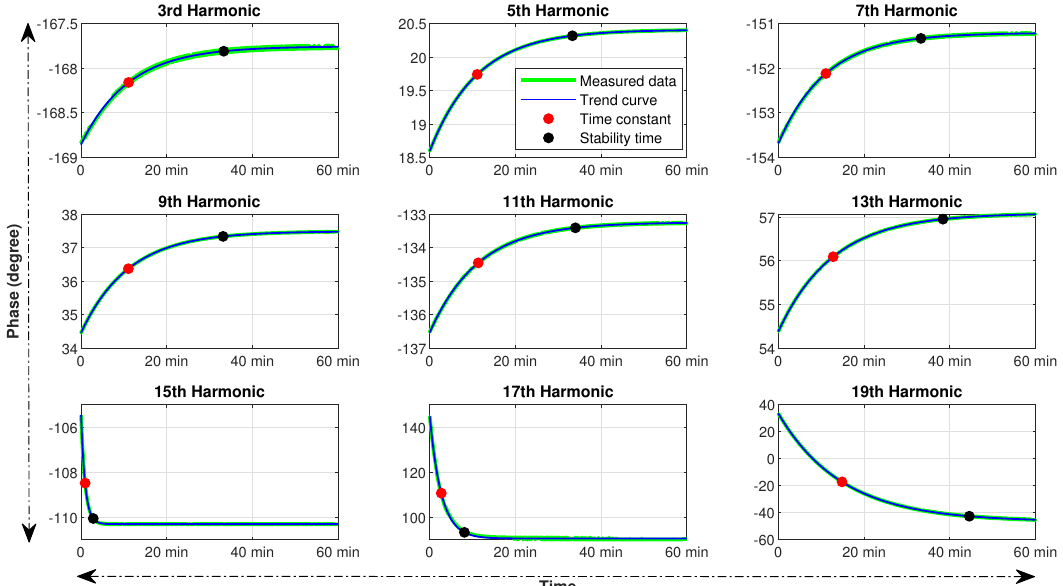
Figure 6. Current harmonic phase variation over time for power supply 3.